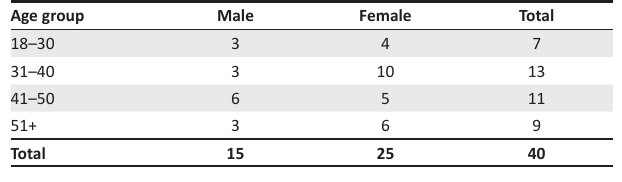
TABLE 1: Gender and age of